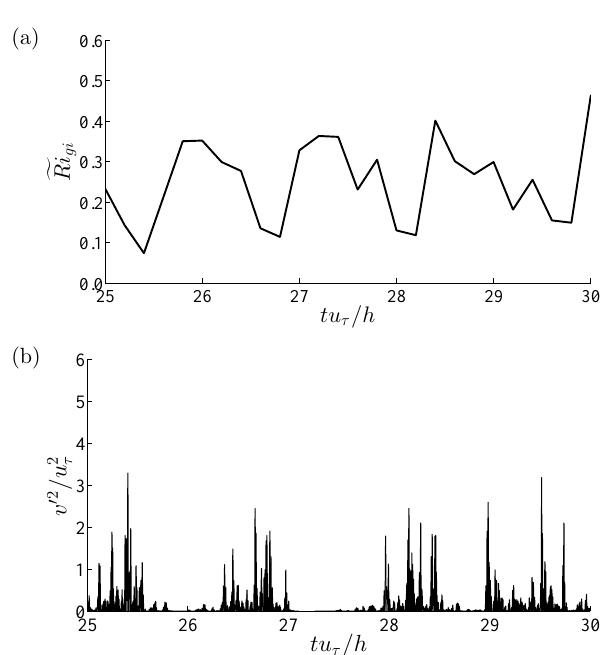
Figure 20. Time series of vertical velocity in the channel. (a) Re τ = 395, Ri τ = 960, and (b) Re τ = 550, Ri τ =